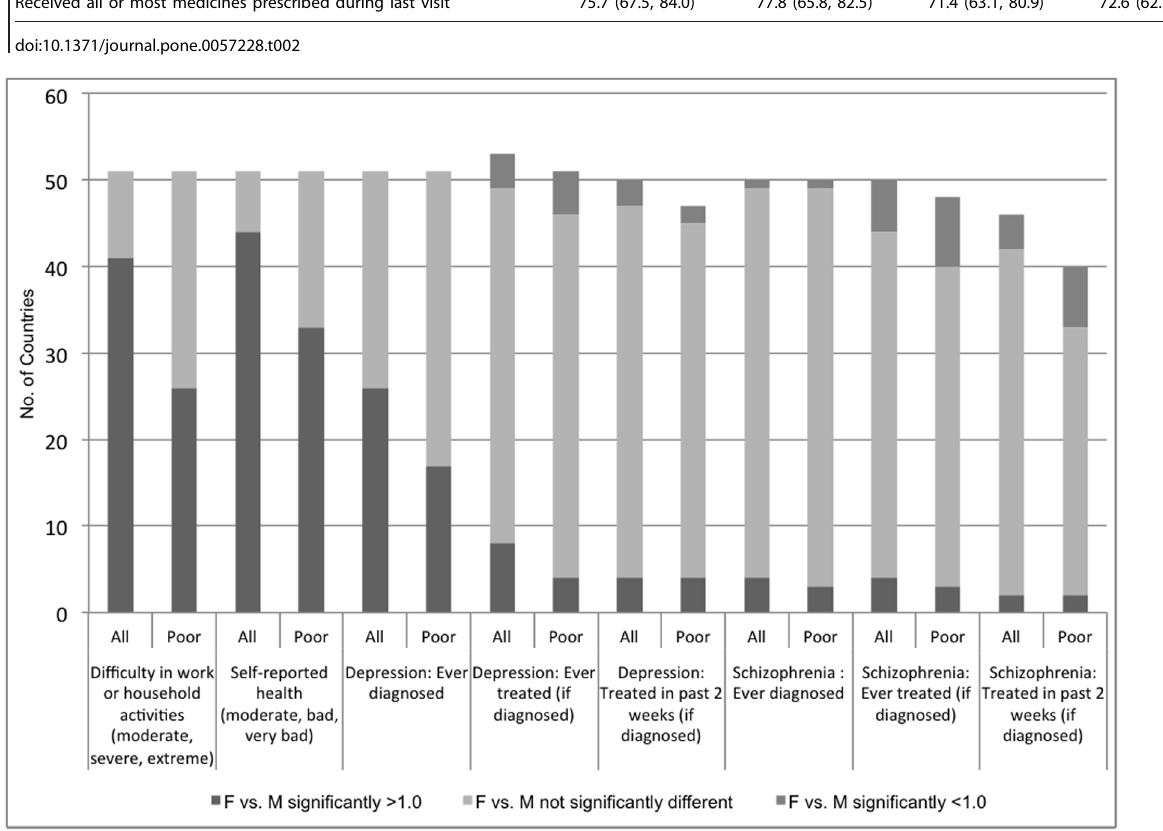
Figure 3. Chronic conditions among adults, number of countries with significant gender differences, all versus poor households. Chronic conditions among adults (activity limitations, self-reported health, depression, schizophrenia), number of countries with significant gender differences, all versus poor households.